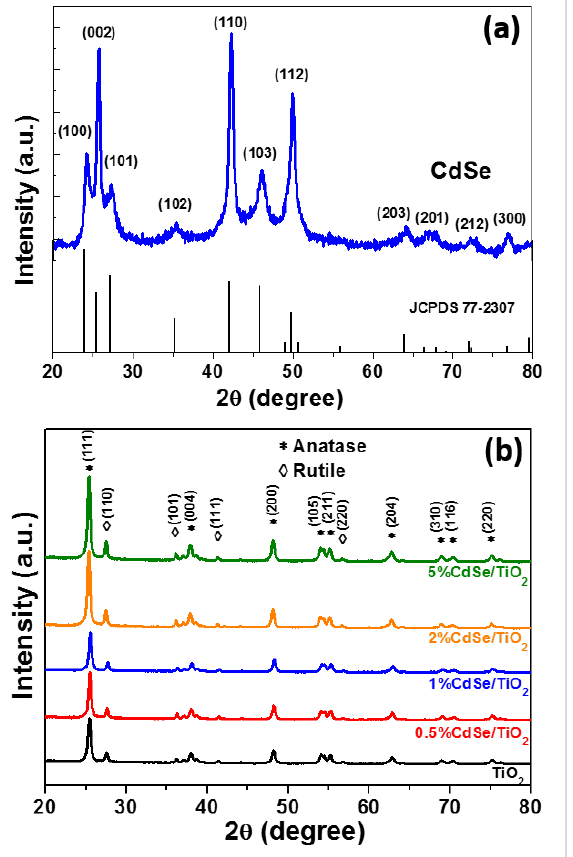
Figure 2: X-ray diffraction patterns of (a) CdSe and (b) TiO 2 and CdSe/TiO 2 composites with varying CdSe wt % from 0.5 to 5 wt %.